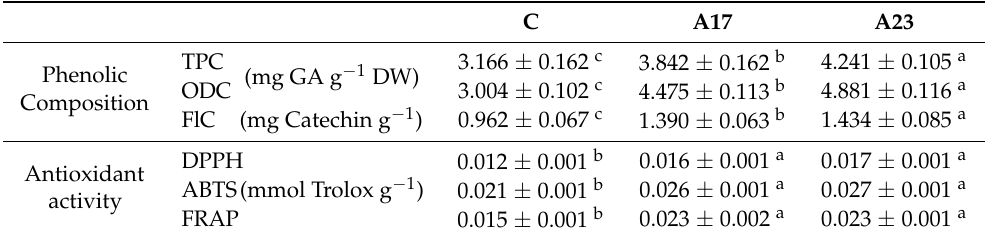
Table 7. Phenolic composition and antioxidant capacity of the GFB with the incorporation of different ratios of apple flour (A17% and A23%) and comparison with the control